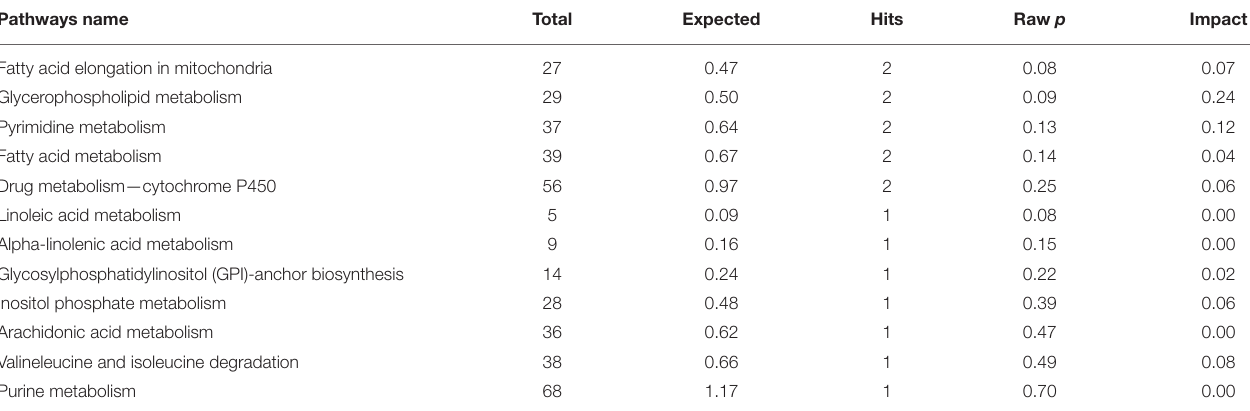
TABLE 4 | Enrichment of pathways involved in unique metabolites of seminal plasma in normozoospermia